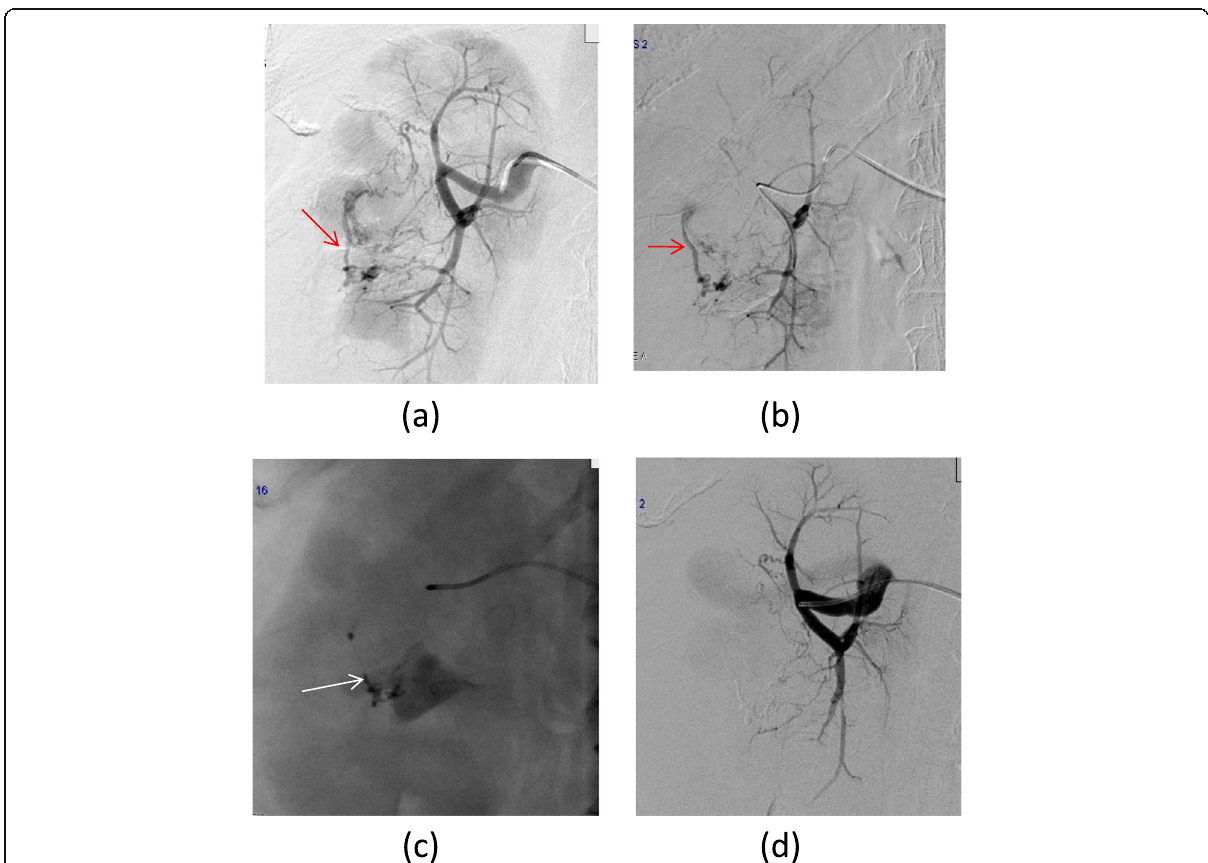
Fig. 4 A 72-year-old woman had continuous hematuria of with the CT diagnosis of right large AVM. Renal angiography with the Cobra catheter ( a , b ) shows the multiple serpiginous abnormal arteries with the ectatic wall in the right kidney (red arrow). NBCA glue was injected by microcatheter to fill the segmental artery that feeds the abnormal vessels (white arrow). Post-embolization angiography ( d ) shows disappearance of these vessels. The surrounding kidney tissues appear